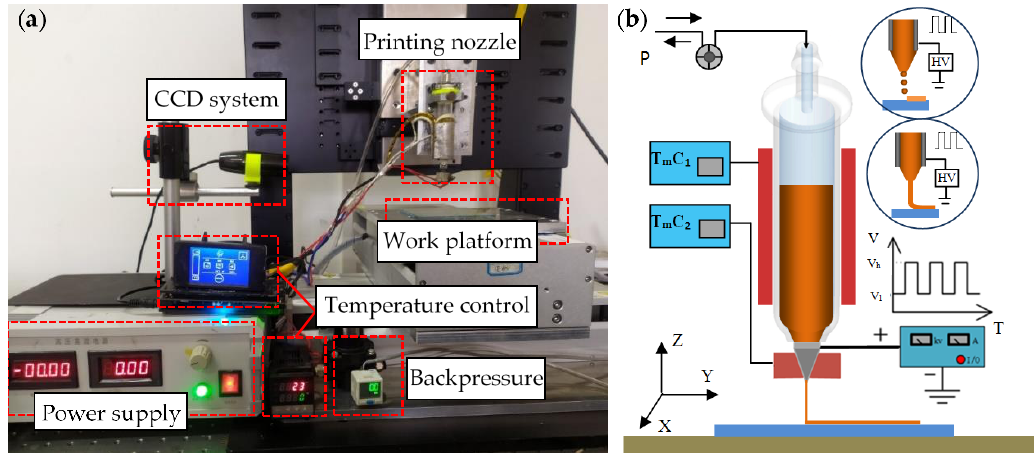
Figure 1. The experimental set up and principle of electric-field-driven (EFD) µ -3D printing: ( a ) the experimental devices. CCD = charge coupled device; ( b ) schematic of the EFD µ -3D printing technology, HV = high voltage.